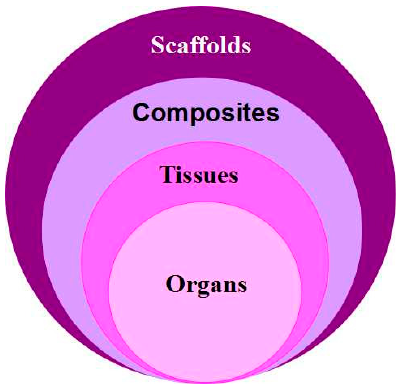
Figure 1. Applications of 3D printing technologies in regenerative medicine: the produced 3D objects can be porous scaffolds, cell/biomaterials composites, homogeneous tissues, or multiple tissues contained organs.